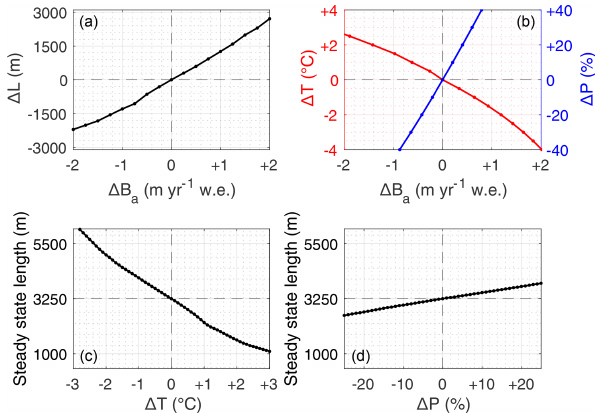
Figure 7. Sensitivity of the Djankuat Glacier showing (a) sensi- tivity of the glacier steady-state length ( (cid:49)L ) to mass balance per- turbations ( (cid:49)B a ) , (b) sensitivity of the mass balance to tempera- ture ( (cid:49)T ) and precipitation ( (cid:49)P ) changes for a fixed present-day glacier geometry, (c) sensitivity of the steady-state glacier length to temperature changes, and (d) the same for precipitation changes. All perturbations are with respect to the 1967/68–2006/07CE refer- ence climate (2.5 ◦ C and 980.7mmyr − 1 w.e.) and with respect to a steady-state glacier with present-day